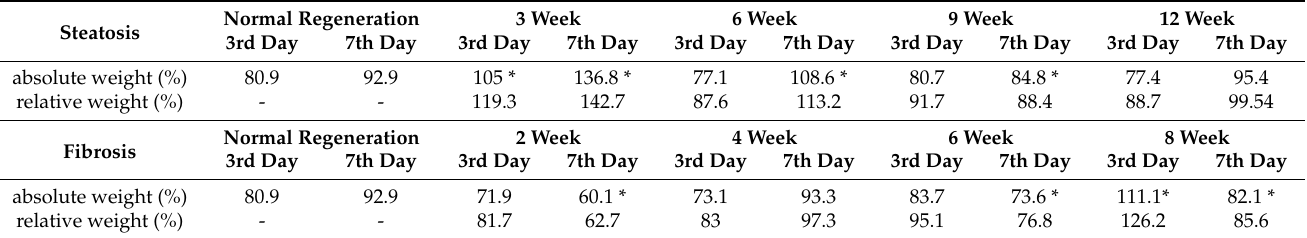
Table 1. Analysis of the recovery of liver